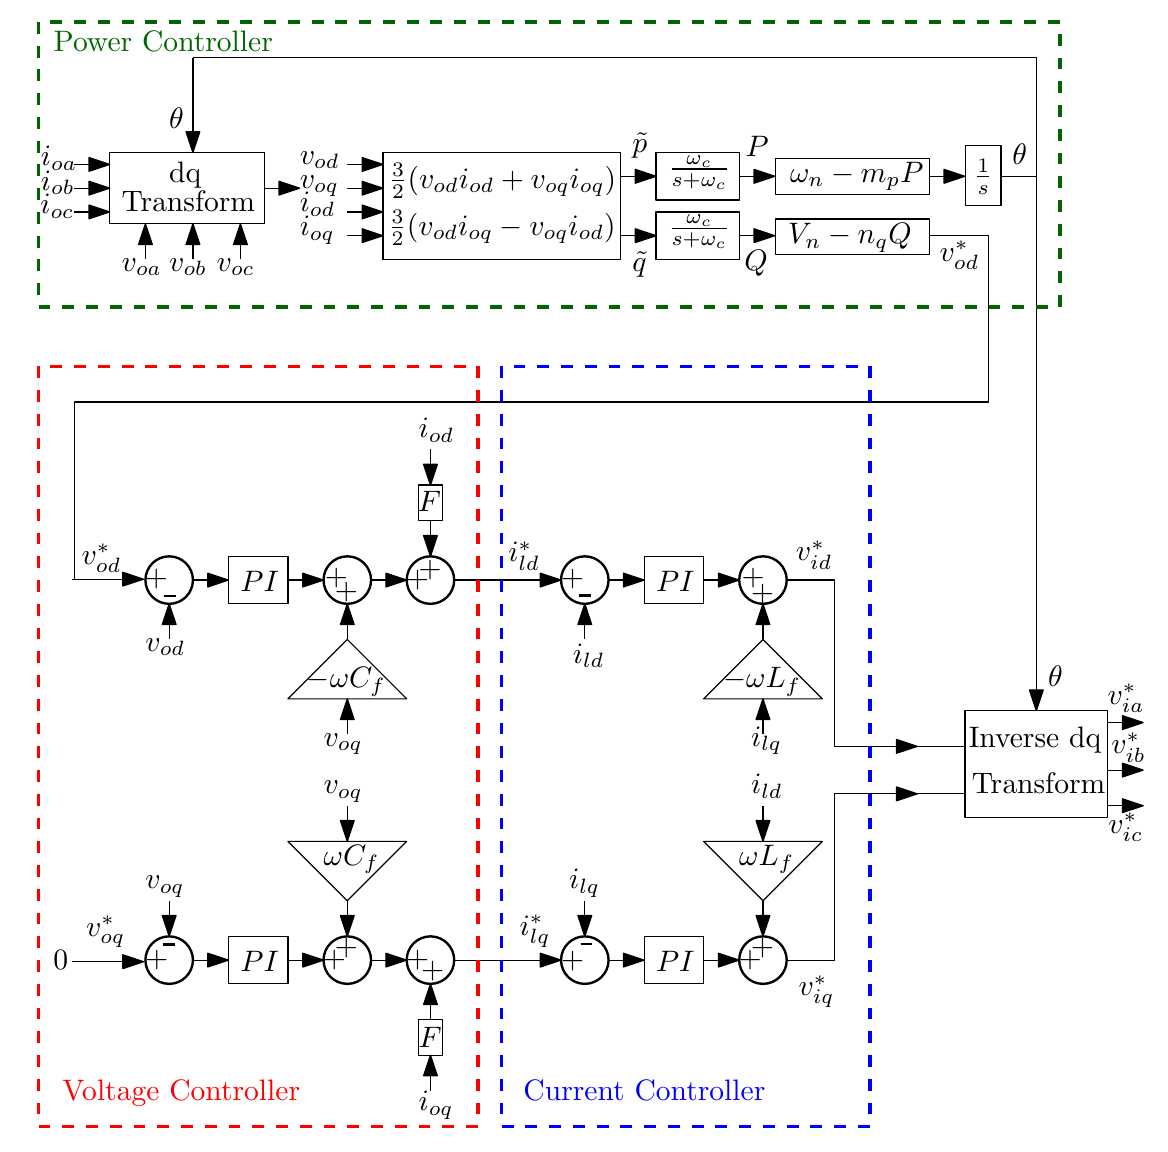
Figure 3. Block diagram of control scheme in dq reference